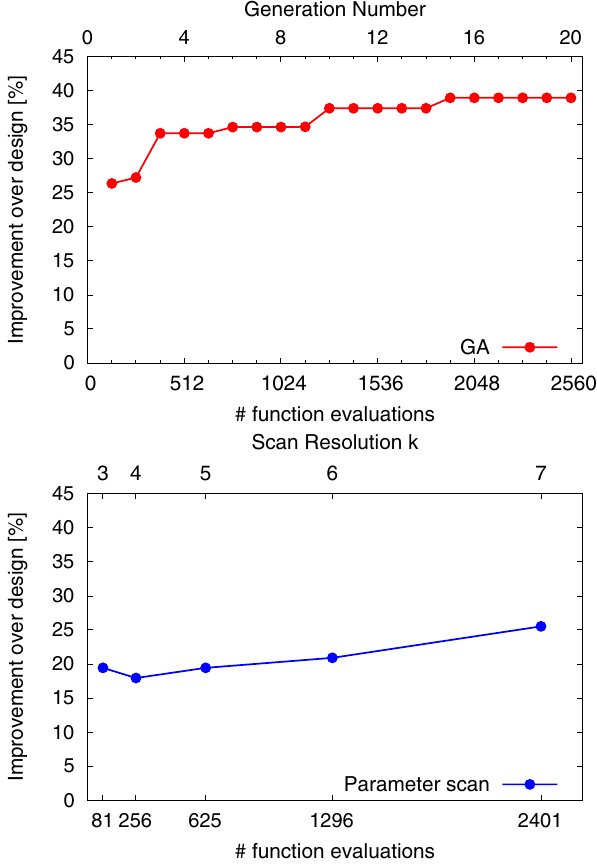
FIG. 6. Top panel: Improvement over the design luminosity after each generation for a GA-based optimization with 20 generations of 128 individuals in each. The improved working point is about 9% better than the one found in Fig. 4. Bottom panel: Improvement over design luminosity after a systematic parameter scan with resolution k in each parameter.